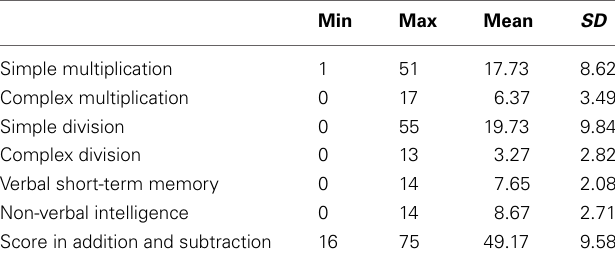
Table A2 | Minimum (min), maximum (max), mean and SD of each